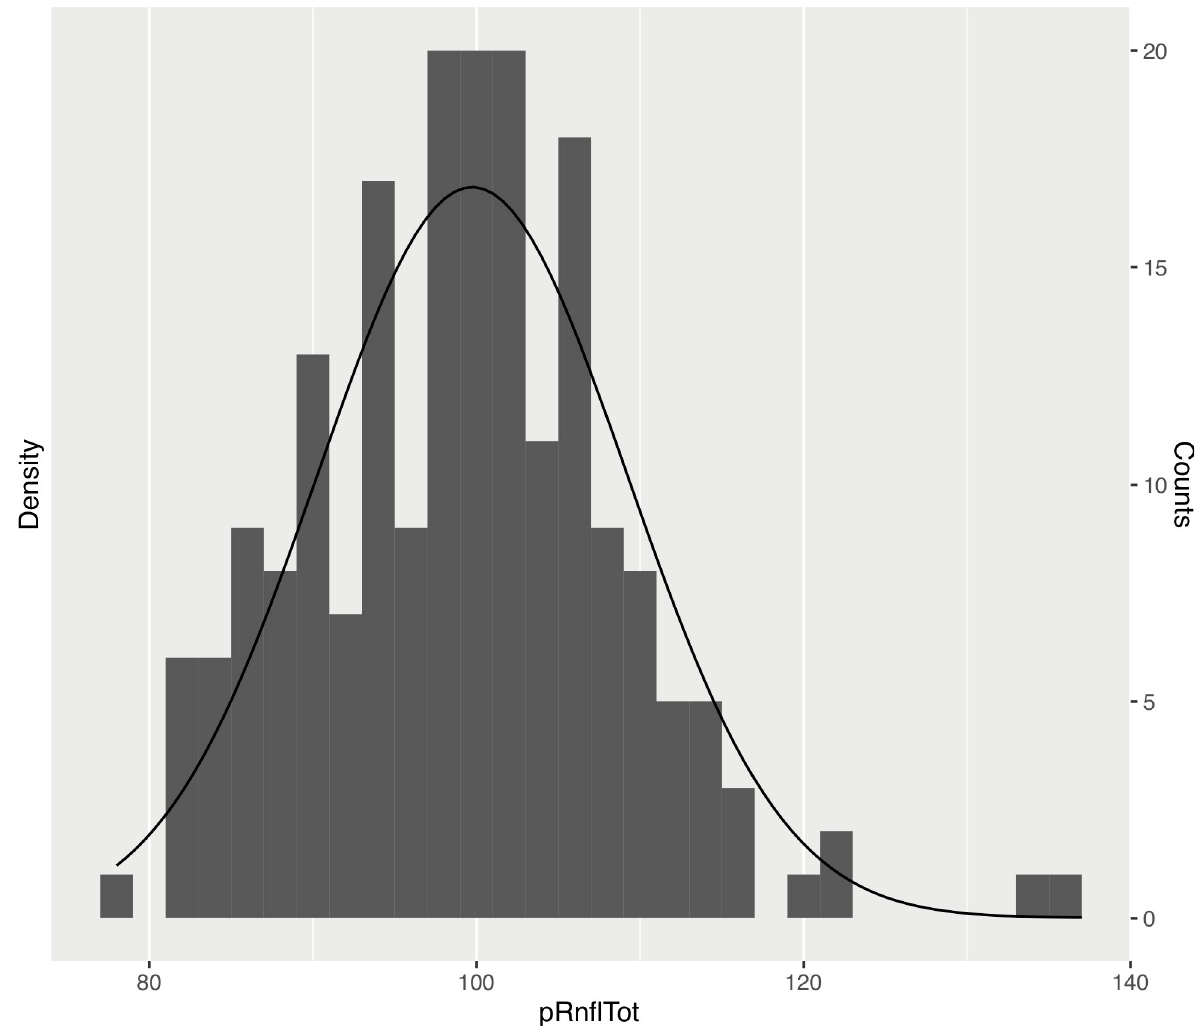
Fig 2. Histogram and fitted normal distribution curve of mean peripapillary retinal nerve fibre layer thickness values.